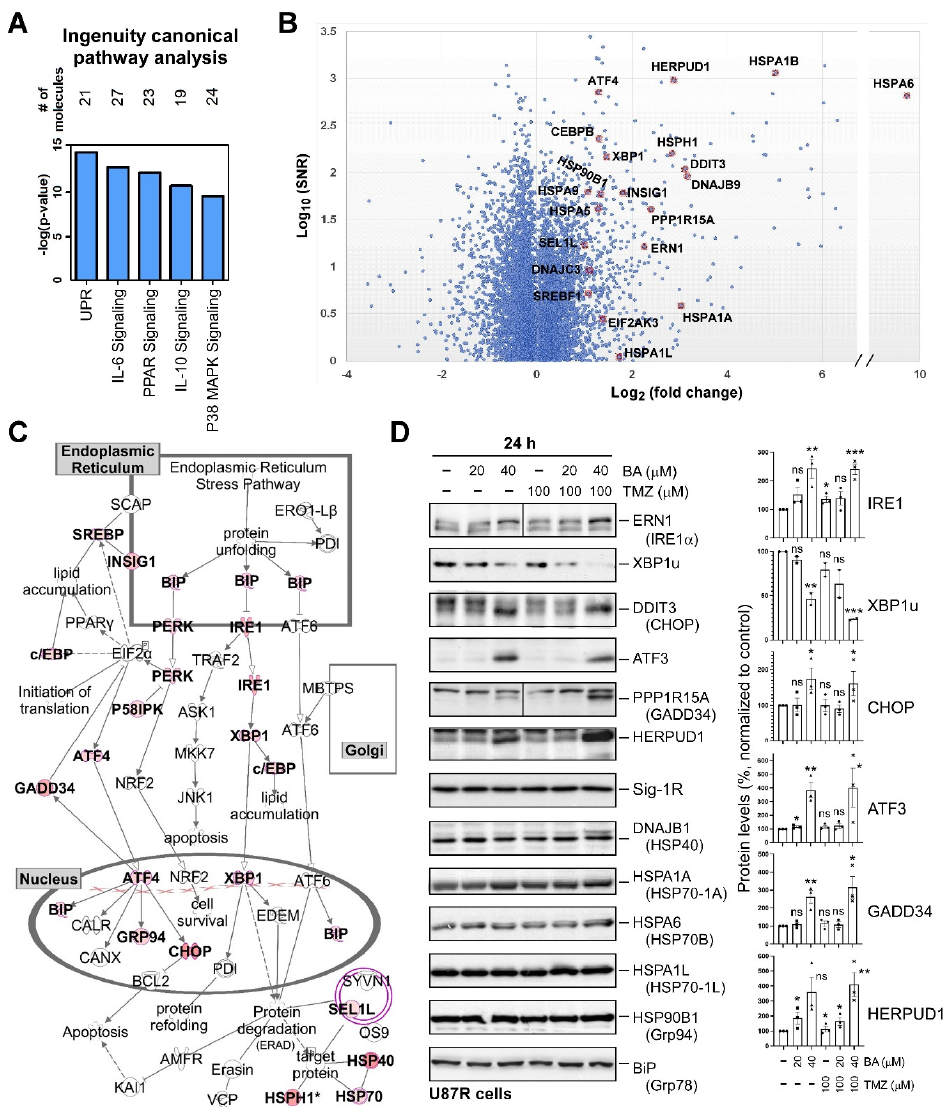
Figure 4. BA treatment alters expression of endoplasmic-reticulum (ER)-stress-related genes: ( A ) 1341 genes showing fold changes of greater than or equal to 2, and p values of less than or equal to 0.05 between BA and DMSO treatment used as input for canonical pathway analysis using IPA software. ( B ) Data for all genes plotted as log 2 fold changes versus log 10 of signal-to-noise ratio. Genes selected as significantly di ff erent and involved in unfolded-protein-response (UPR) signaling highlighted as red dots. ( C ) UPR pathway generated by IPA software. Colored molecules represent genes a ff ected under BA treatment. Red molecules indicate upregulated genes. ( D ) U87MG cells collected 1 day after treatment with BA and / or TMZ at di ff erent concentrations. Cellular lysates were then analyzed by Western blotting with indicated antibodies. (Right panel) Protein levels of IRE1, XBP1u, CHOP, ATF3, GADD34, and HERPUD1 normalized to tubulin. Data presented as means ± standard deviations (t-Test: * p < 0.05, ** p < 0.01, and *** p < 0.005; ns: not significant). For more details of Western blot, please view Supplementary